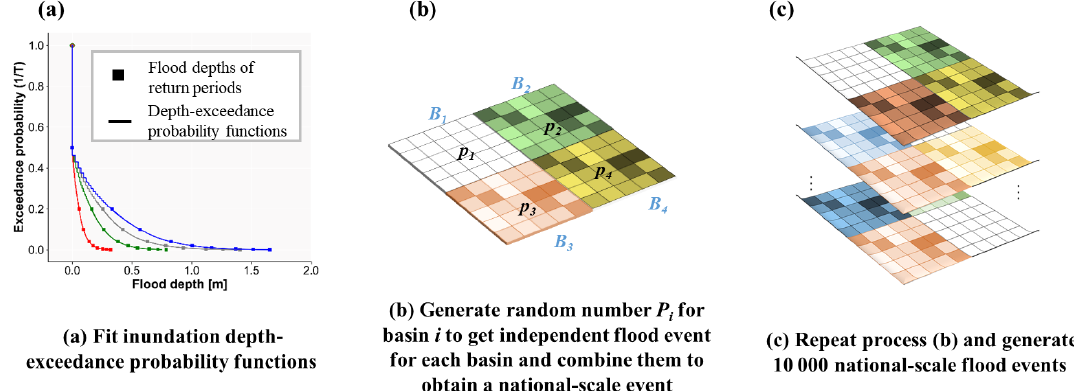
Figure 3. An example of generating national-scale flood events. In (b) , p 1 , p 2 , p 3 , and p 4 are the random numbers between 0 and 1 generated for basins B 1 , B 2 , B 3 , and B 4 , which are used to generate basin-scale events based on the functions in (a) . The layers of basin-scale floods in (b) are combined into a national-scale flood event. The layers in (c) are the 10000 national-scale events using the process in (b)